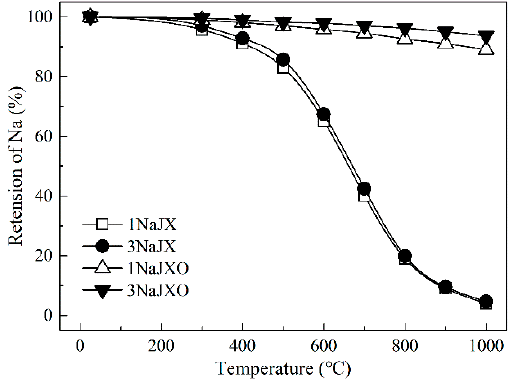
Figure 1. The retention of Na (%) in different chars at pyrolysis.